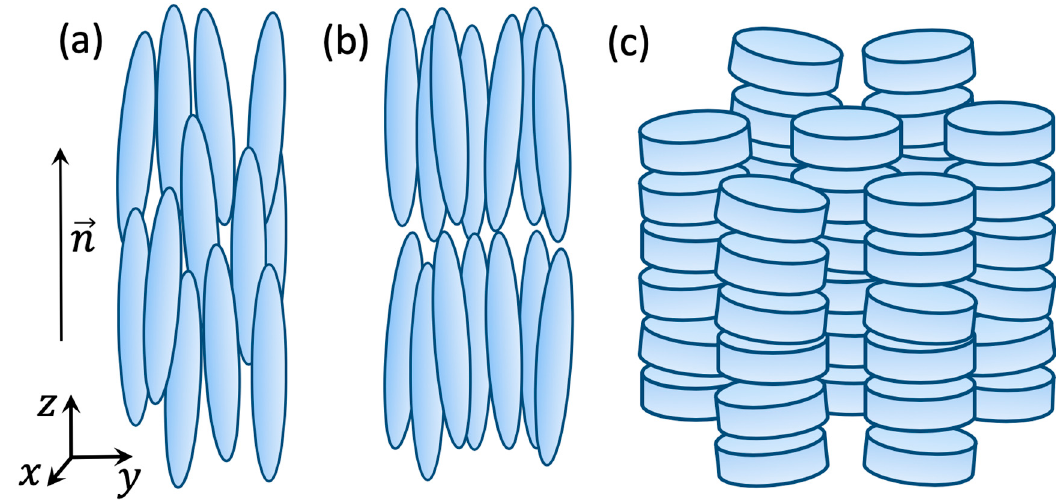
Figure 2. Schematic representation of different LC phases. ( a ) The nematic phase, in which elongated molecules are preferably aligned along the director n ; ( b ) The smectic-A phase, in which elongated molecules form parallel layers in addition to the nematic orientational order; ( c ) The columnar phase, in which aligned disc-like molecules form 2D lattice of columns.